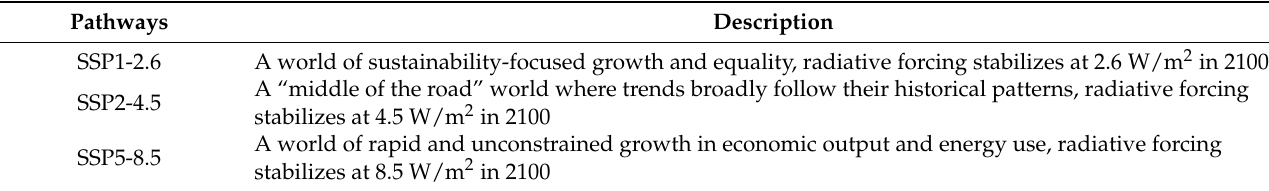
Table 2. Explanation of the three shared socioeconomic